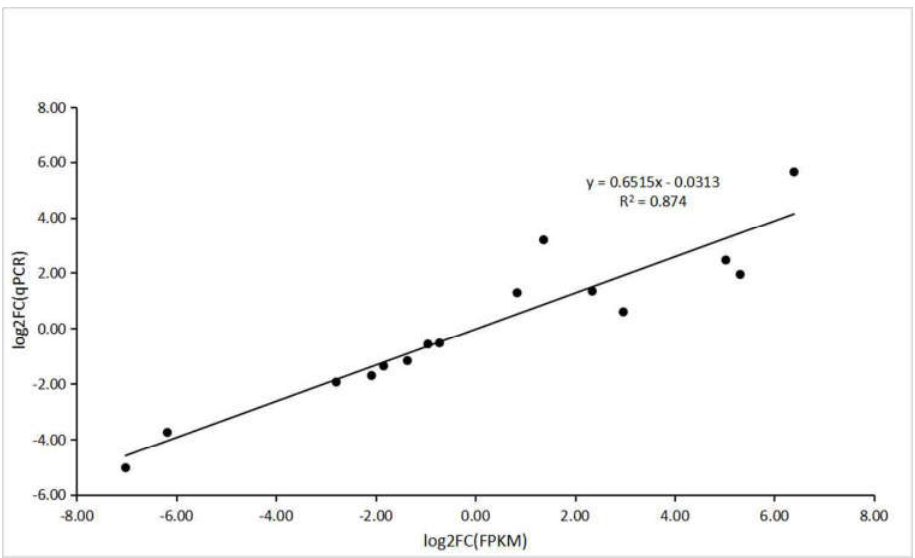
Figure 12. The correlation analysis between RNA-seq and qRT–PCR.